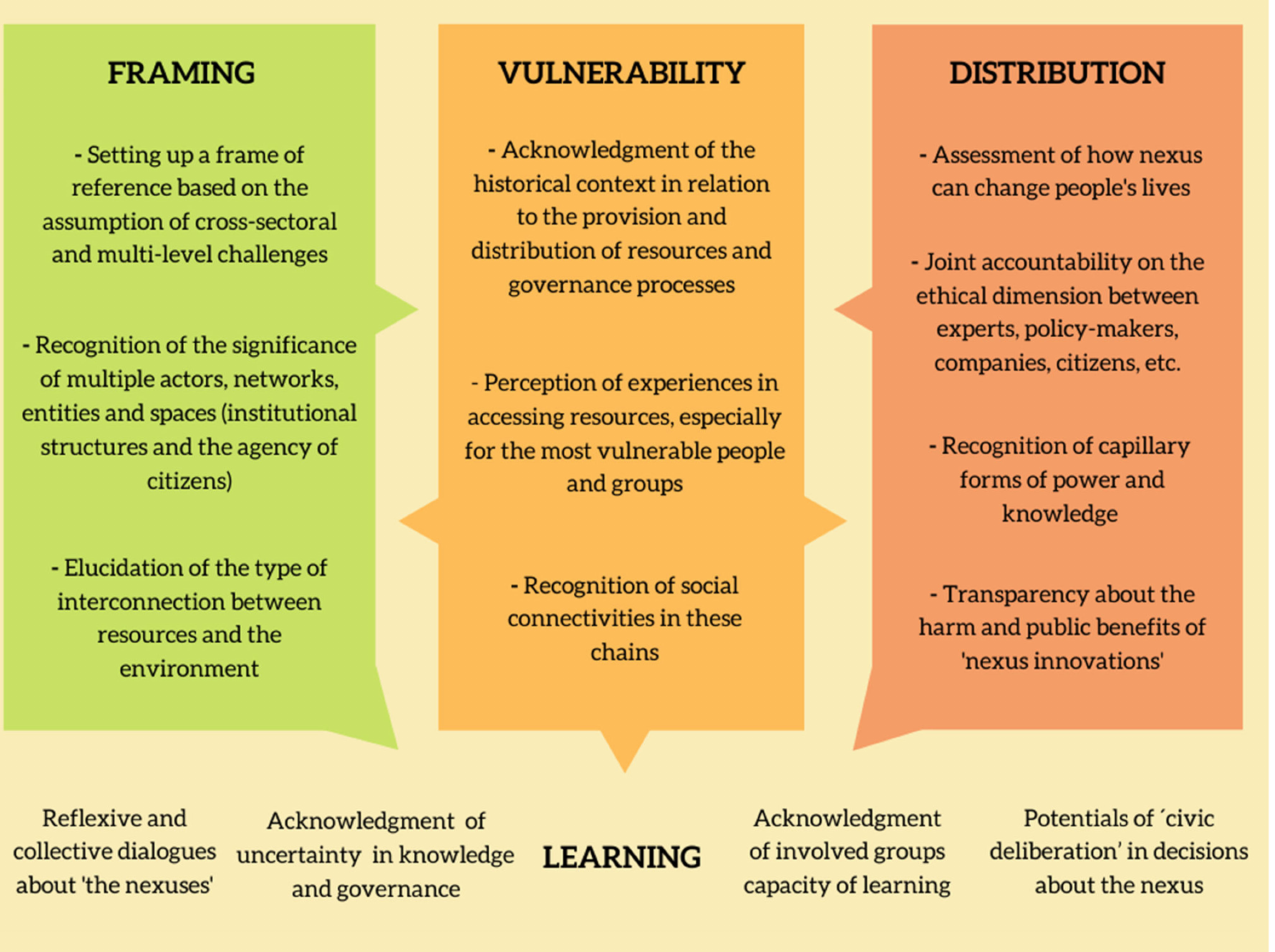
Figure 1. Conceptual framework of the ‘nexus of humility’ as a pathway to Sustainability. Adapted from Jasanoff [15,16], Leach et al. [8,17], and Urbinatti et al.